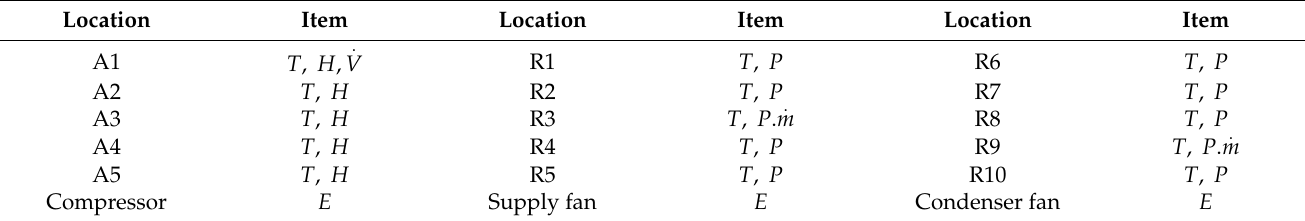
Figure 6. System diagram and data measurement locations for the 20 RT (70 kW) air conditioner system. Table 4. Measurement location and item.